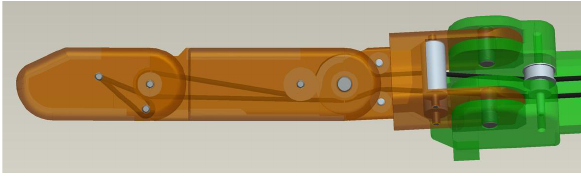
Figure 5. CAD model of the